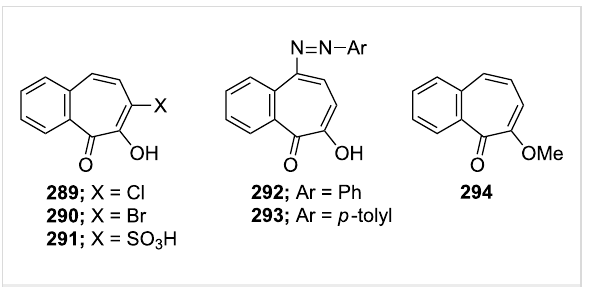
Figure 12: Various monosubstitution products 289 – 291 of 7-hydroxy- 2,3-benzotropone ( 241 ).